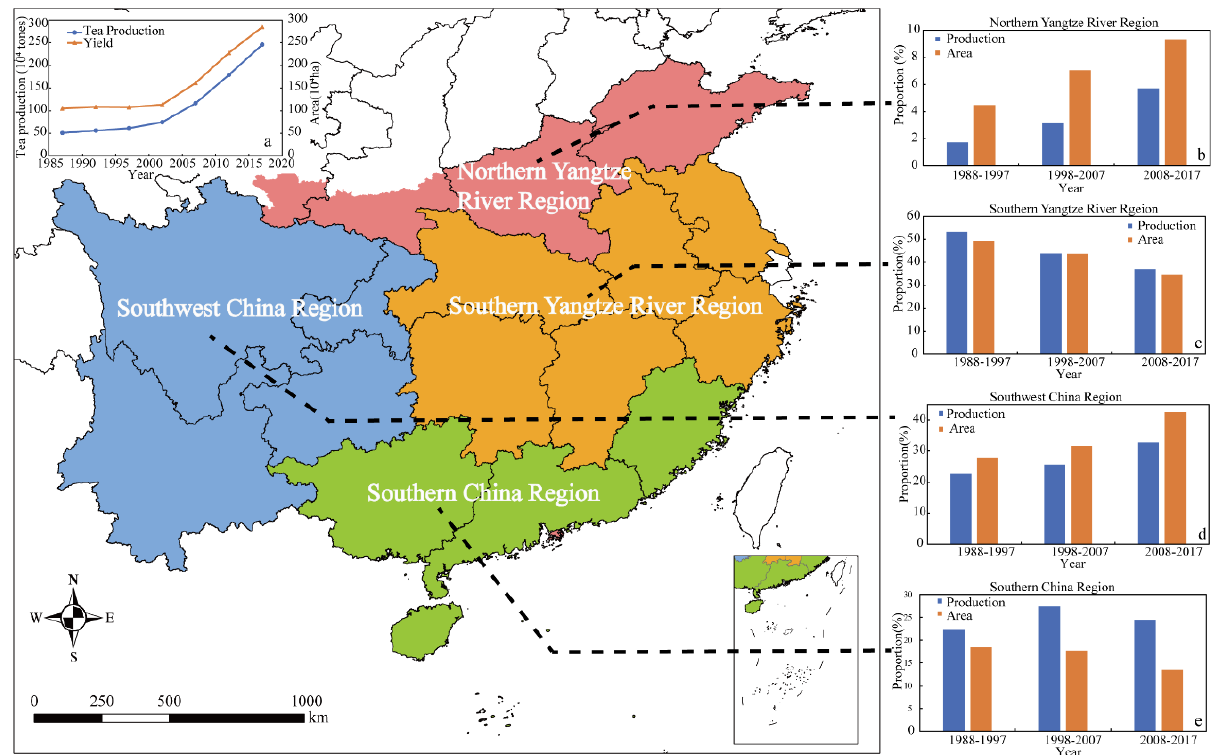
Figure 1. Distribution of climatic tea zoning in mainland China and changes of tea planting area and yield; ( a ) time-series changes of five-year mean tea planting area and total production in China from 1987 to 2017; and changes of ten-year mean tea planting area and yield proportion in Northern Yangtze River Region ( b ), Southern Yangtze River Region ( c ), Southwest China Region ( d ), and Southern China Region ( e ).